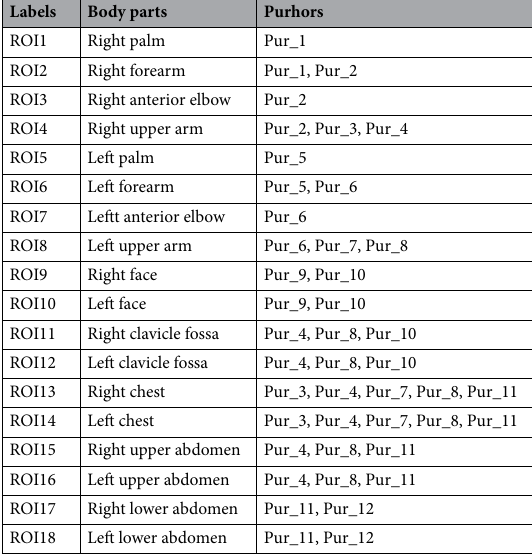
Table 2. The relationship between theROI labels and the Purhor